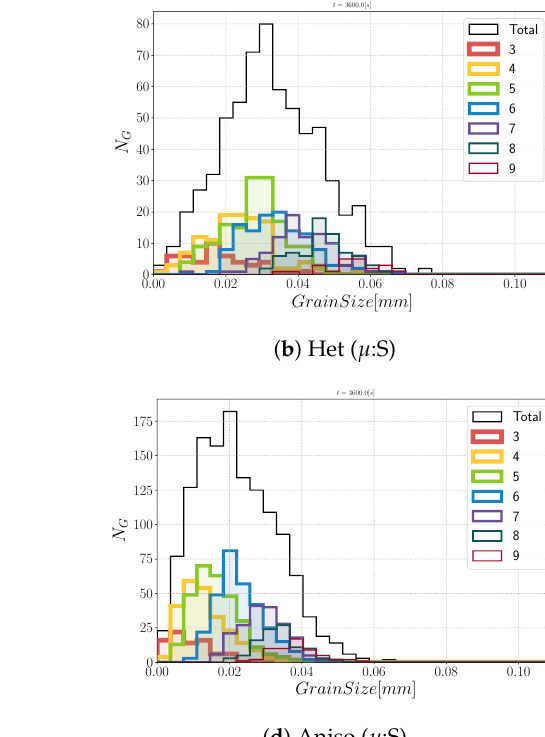
Figure B.8. Equivalent radius distribution and contribution from every group of grains with coordination number from 3 to 9 at t = 1 h .